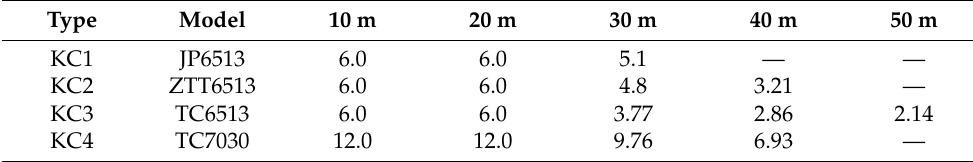
Table 3. Lifting capacity of optional tower cranes.